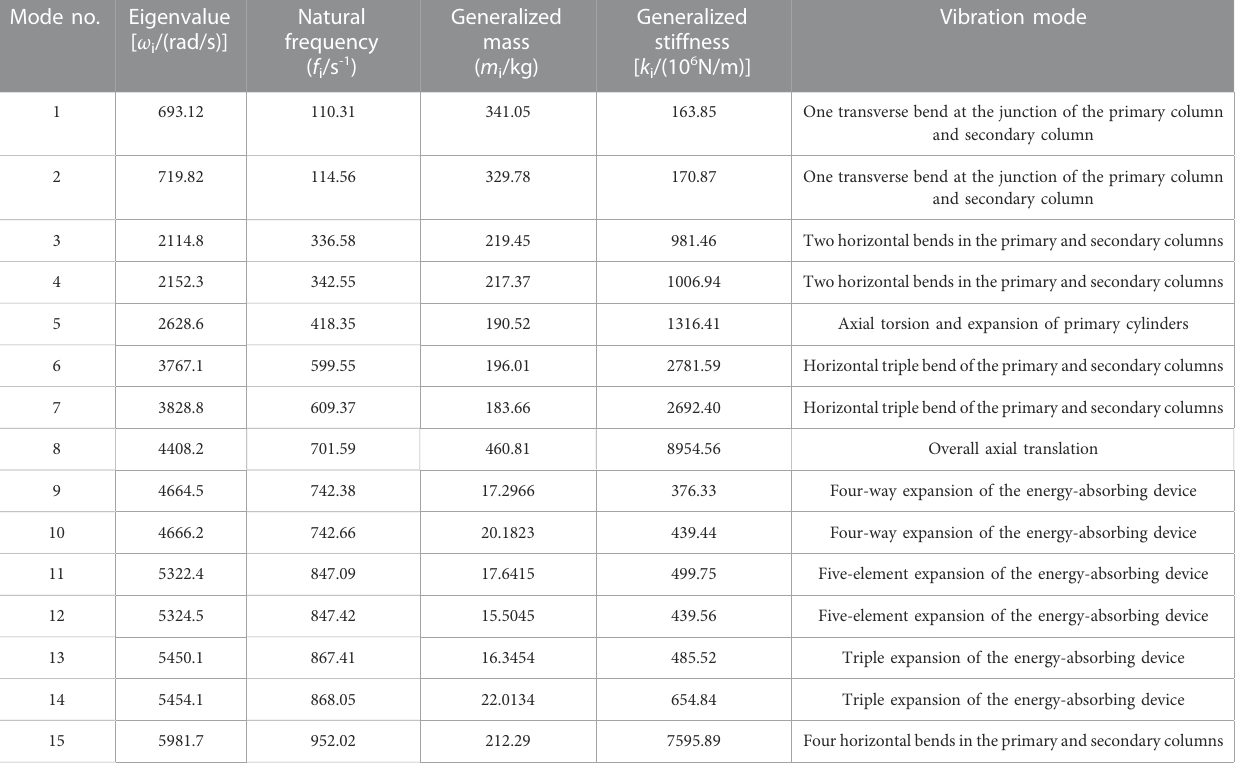
TABLE 3 Frequency and vibration mode for the fi rst 15 orders of the energy-absorbing and anti-scouring column. Mode